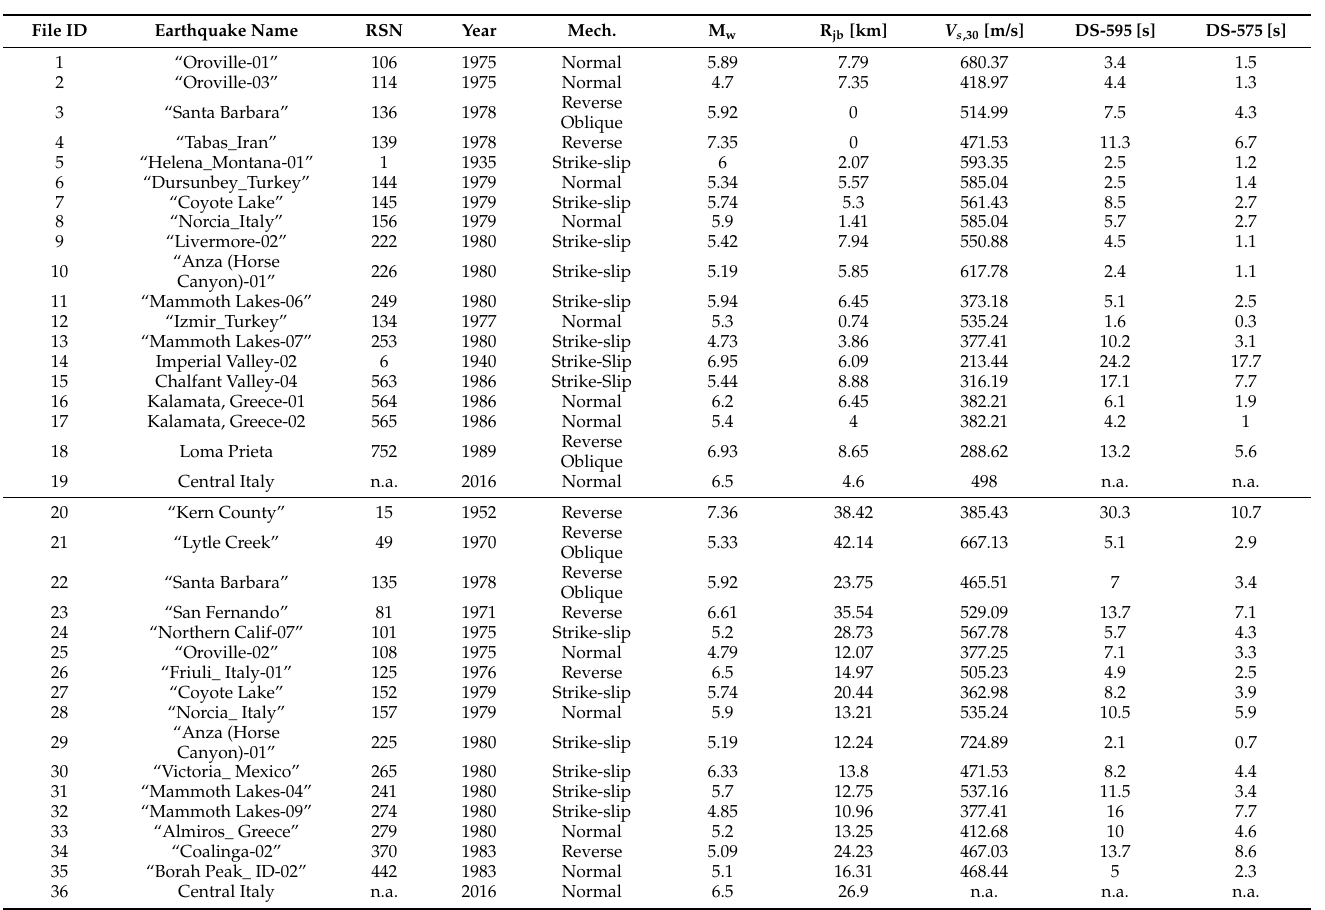
Table 1. Details of the two subsets of ground motion data deepened for the study based on the NGA—West 2